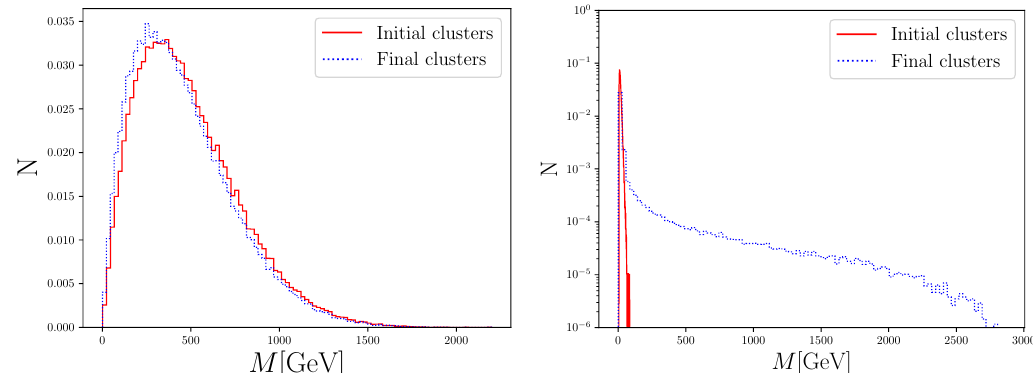
Figure 2 . Invariant mass distribution of 5 clusters before and after mesonic colour reconnection for RAMBO(left) and UA5(right) kinematics.